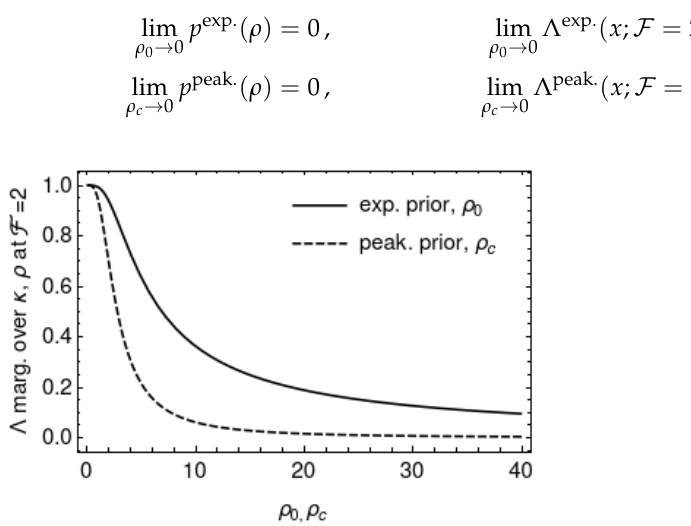
Figure 5. The likelihood ratios marginalised over κ and ρ with the exponential (Equation (23)) and peaked (Equation (25)) priors, as functions of the priors’ respective parameters ρ 0 and ρ c , at fixed = F